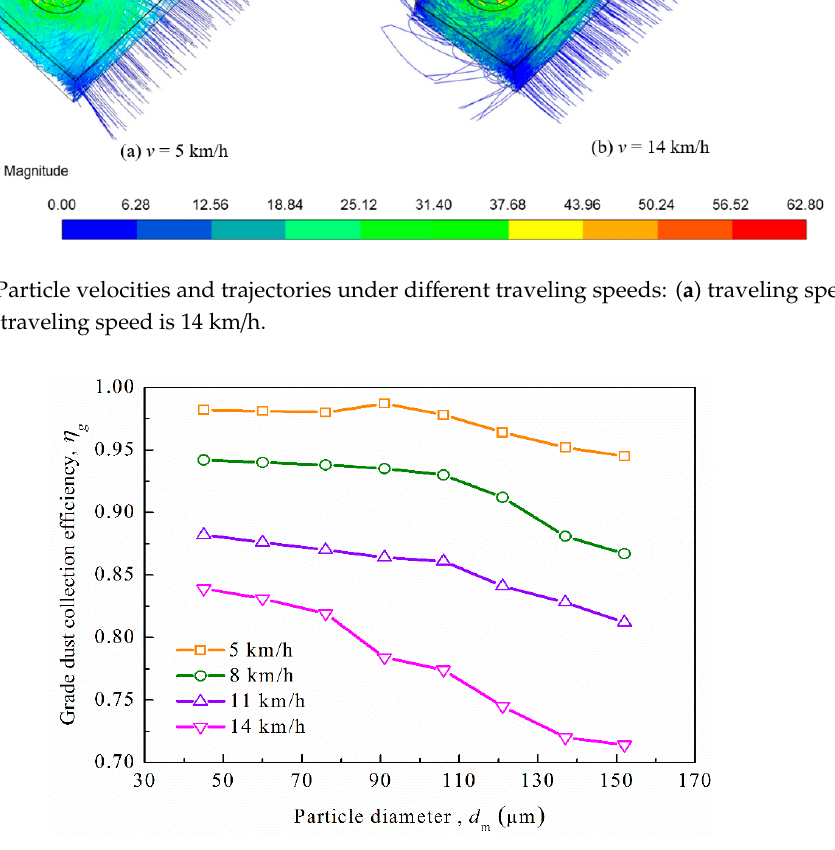
Figure 13. Particle velocities and trajectories under different traveling speeds:( a ) traveling speed is 5 km/h; ( b ) traveling speed is 14 km/h;